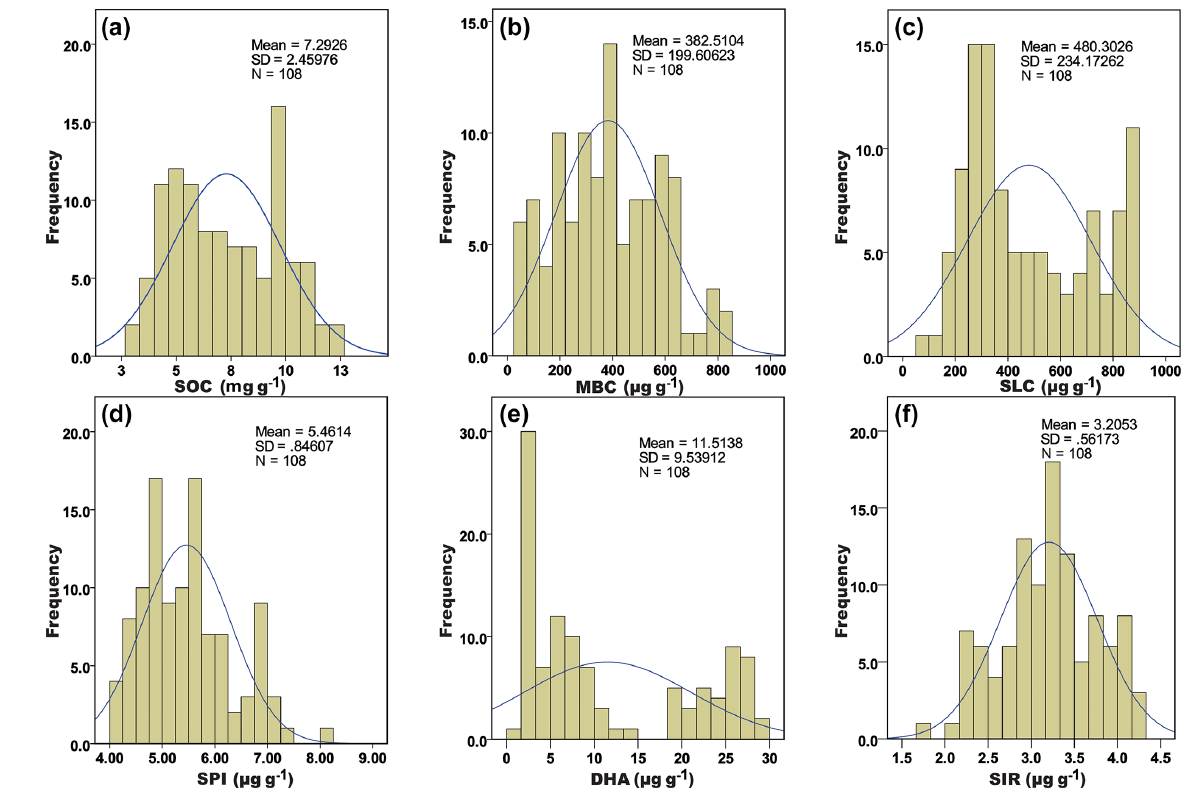
Figure 1. Histogram and distribution curve (bell curve) of the observed soil biological variables from four different nutrient management plots of three different agroclimatic zones of Tamil Nadu, India. A – soil organic carbon; B – microbial biomass carbon; C – soil labile carbon; D – soil protein index; E – dehydrogenase activity; F – substrate-induced respiration.